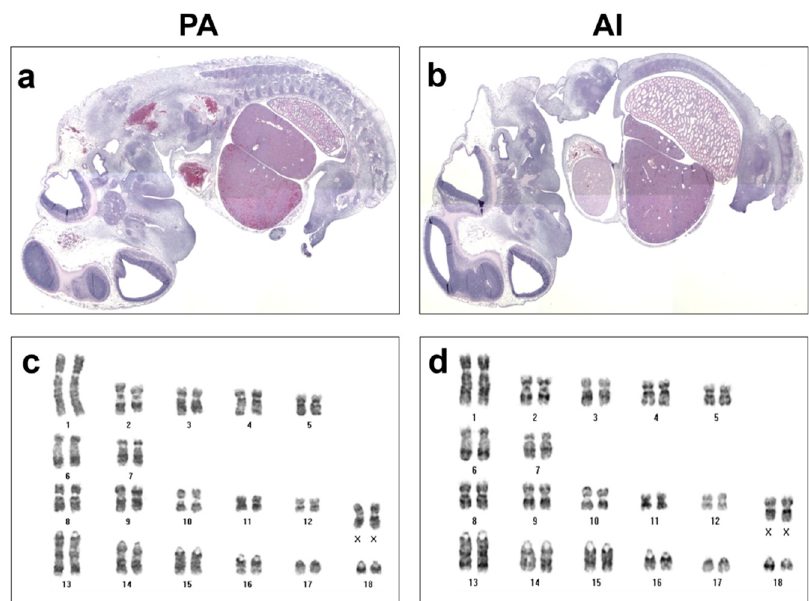
Figure 2. Developmental characteristics of PA and AI embryos. PA and AI embryos at day 26 were embedded in paraffin and sectioned in sagittal planes ( a , b ). Cell lines were established from both PA and AI embryos and subjected to karyotyping ( c , d ).